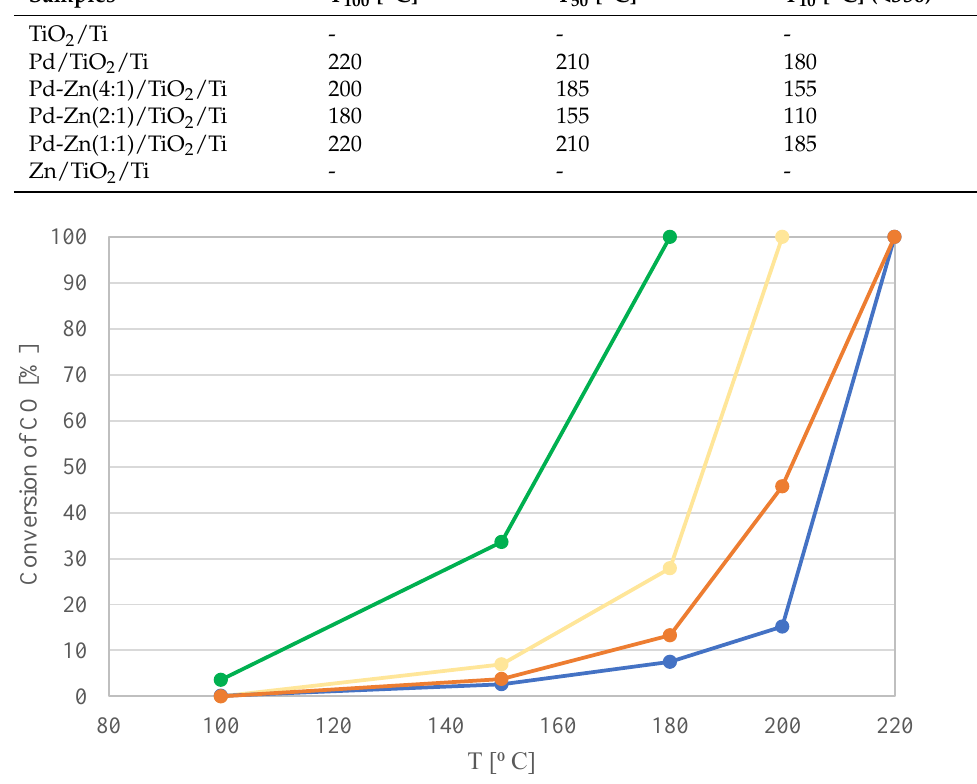
Figure 1. Catalytic activity of Pd and Pd–Zn/TiO 2 /Ti wire catalysts in different proportions: Pd/Zn = 4:1; Pd/Zn= 2:1; Pd/Zn = 1:1; Pd.